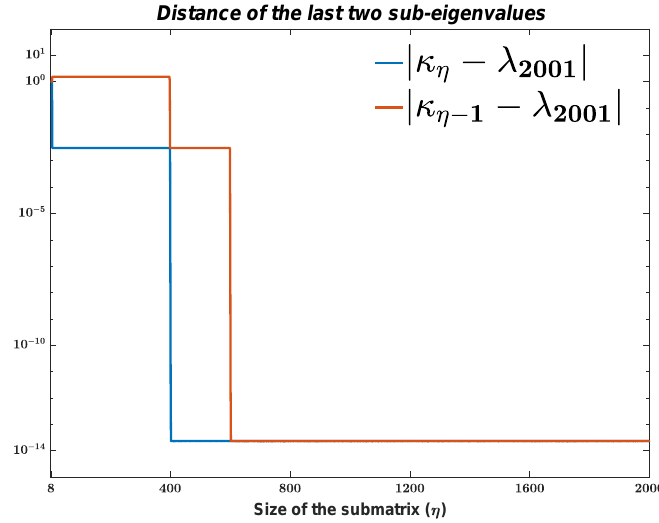
Figure 2. The distances of the last two